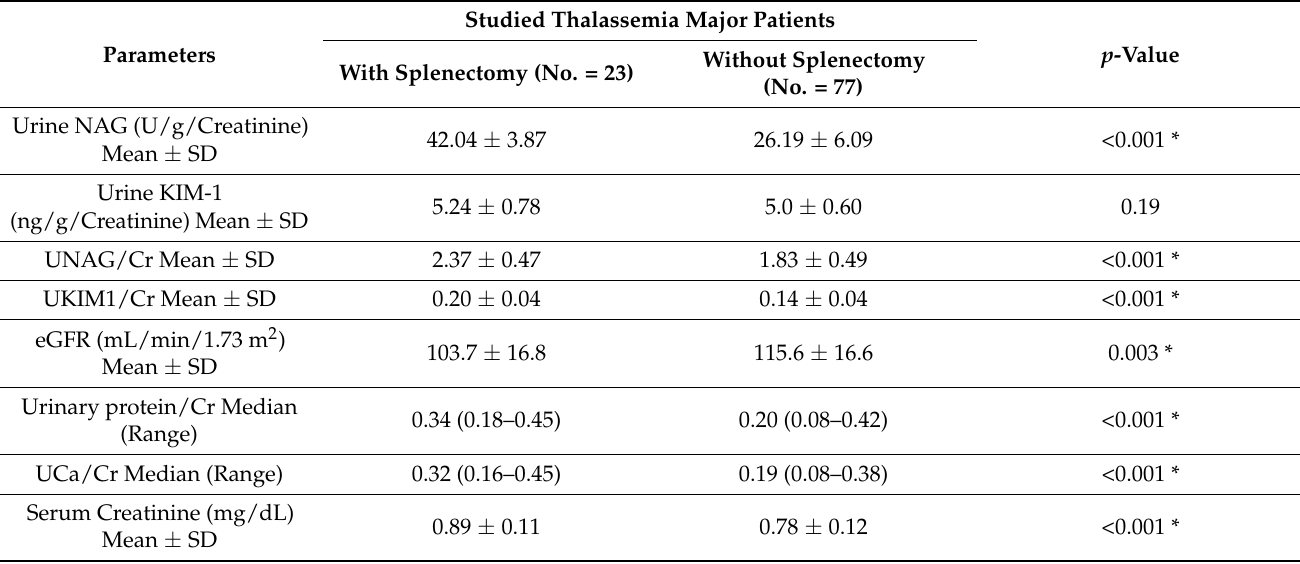
Table 6. Urinary NAG and KIM-1 among studied thalassemia major patients regarding